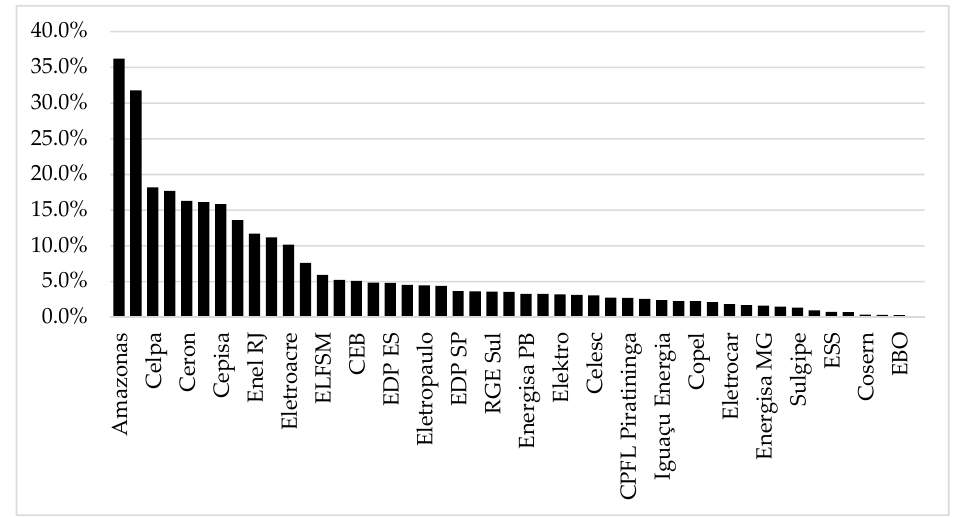
Figure 2. Percentages of non-technical losses (PNTLs) in the total energy injected into the utility grids in 2018 by main utilities [9].